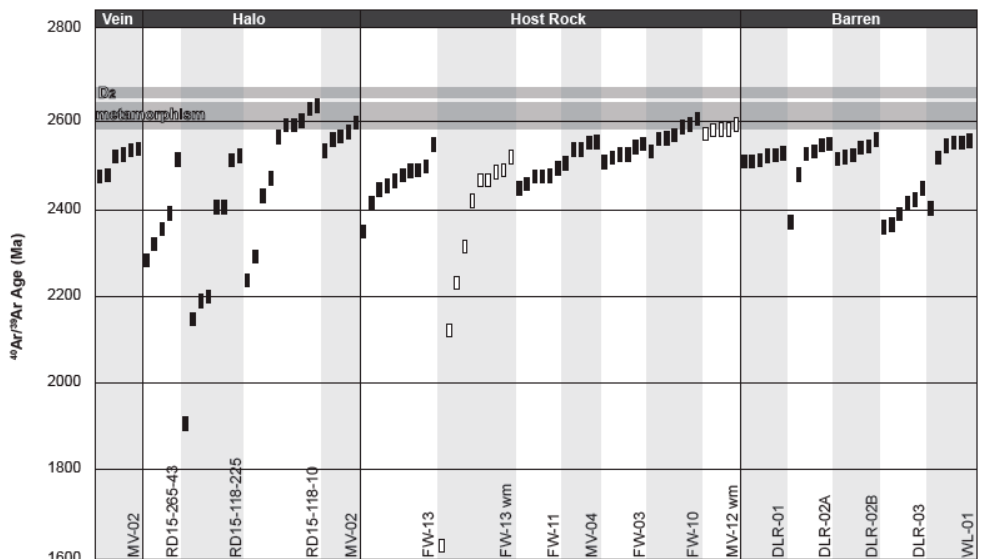
Figure 7. Diagram showing single crystal 40 Ar / 39 Ar ages from biotite (black bars) and muscovite (white bars) from fifteen samples (ten mineralized; five barren) representing the four mica types. The height of each bar represents the ± 10 m.y. uncertainty of the apparent age that we applied to all samples as an average error. Note that all four biotite types yield similar ages that significantly postdate the timing of major deformation events, regional metamorphism and gold mineralization.